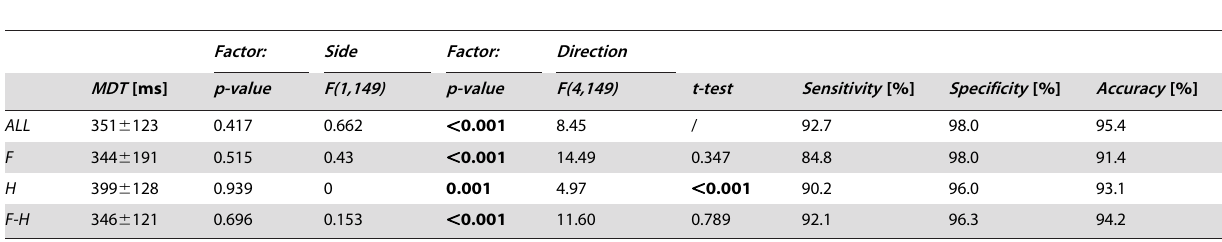
Table 1. The table shows the Mean Detection Time ( MDT ), Sensitivity , Specificity and Accuracy for the all-segments combination ( ALL ) and the reduced-segments combinations chosen after the Ranking .